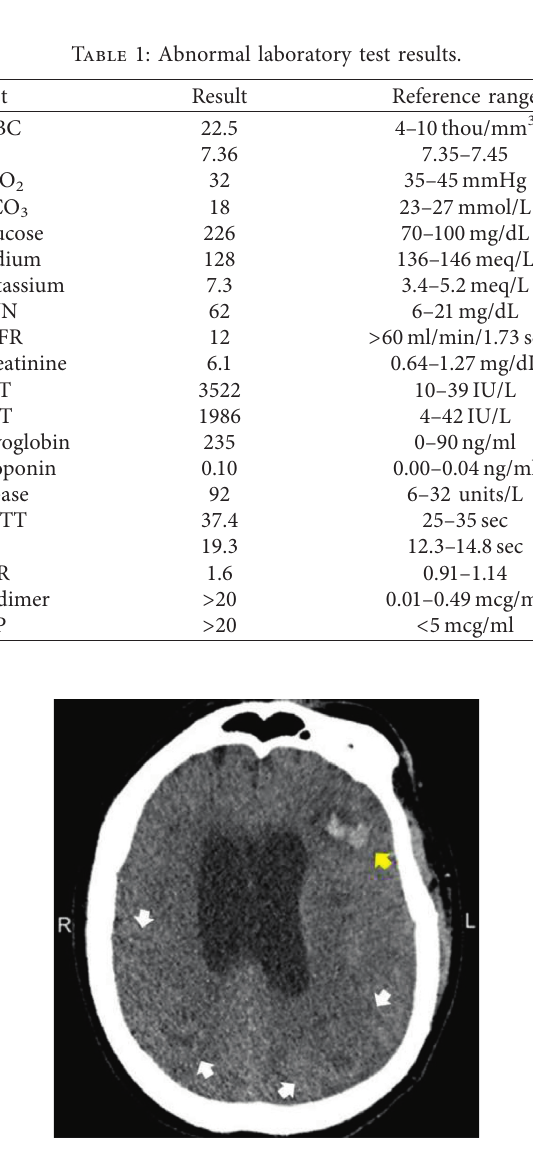
Figure 1: CTscan of the brain showing multiple areas of decreased attenuation in the bilateral occipital lobes and the right parietal lobe (white arrows); subacute intraparenchymal hemorrhage is present in the left frontal lobe (yellow arrow). R, right lateral; L, left